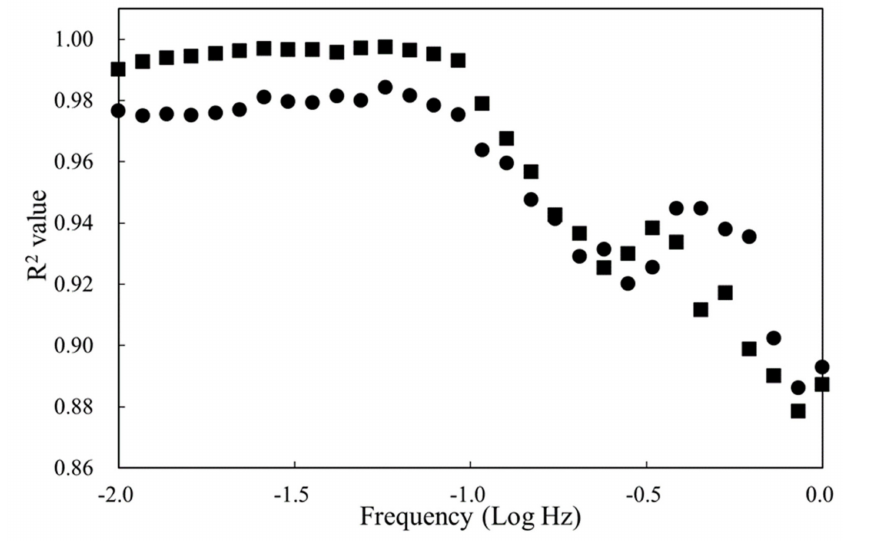
Figure 6. Linear regression results of Log Z at different frequency against AV ( (cid:4) ) and TPC ( • ). R 2 : coefficient of determination of the corresponding linear